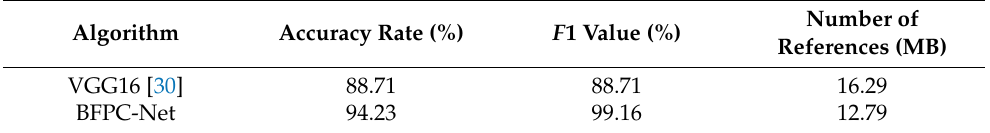
Table 5. Model performance